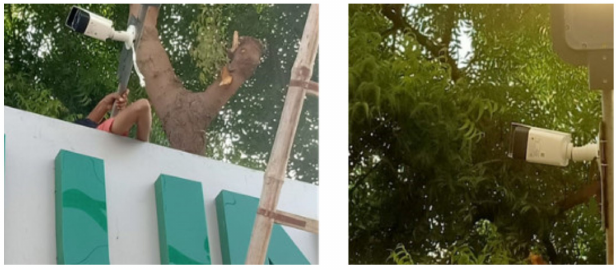
Figure 5. Pictorial view of the installed